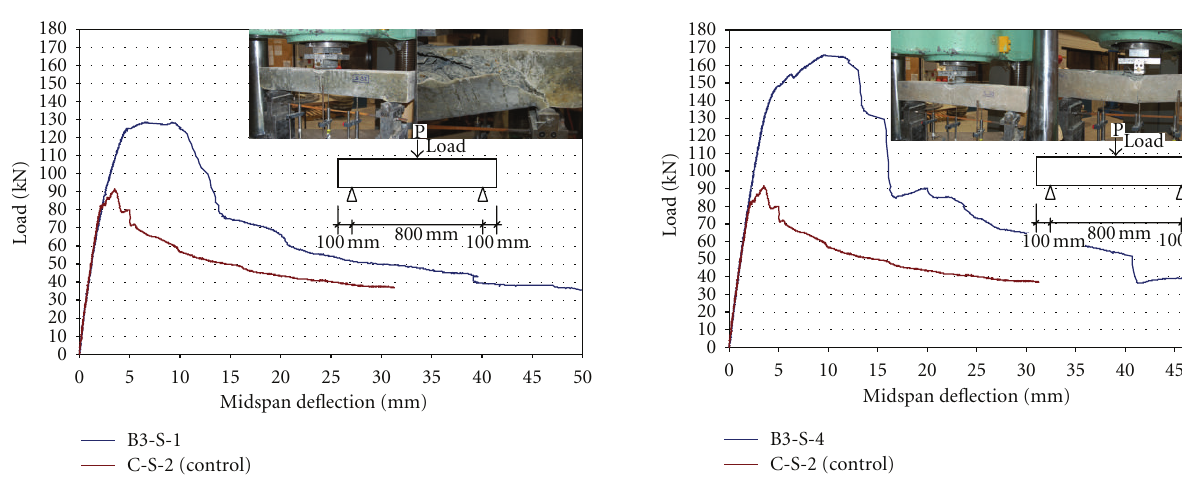
Figure 34: Load versus midspan deflection of RC beam B3-S-1.